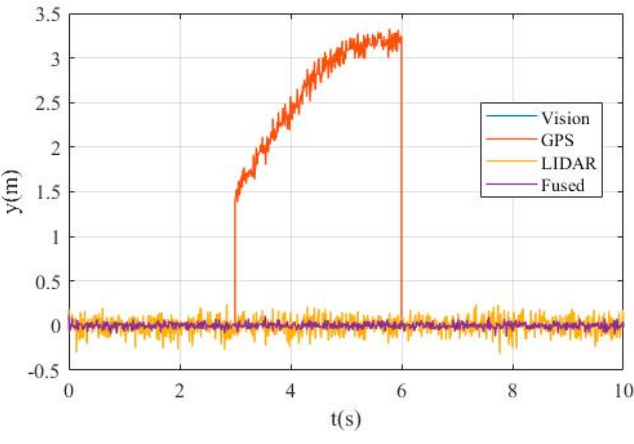
Figure 10. The lateral position error.